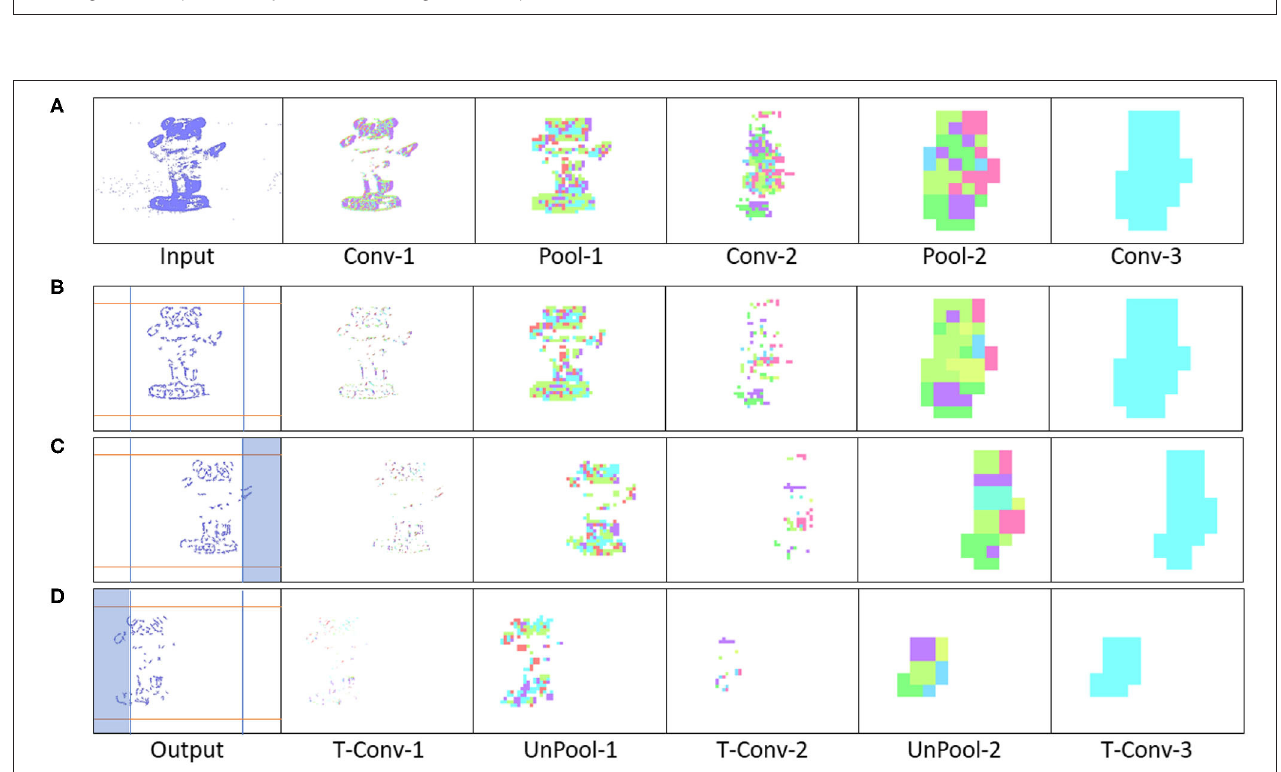
FIGURE 12 | (A) Panda Input Image, (B) Panda being in the middle in the field of view, (C) Panda reaching rightmost boundary triggering a control action, (D) Panda reaching leftmost boundary triggering a control action.